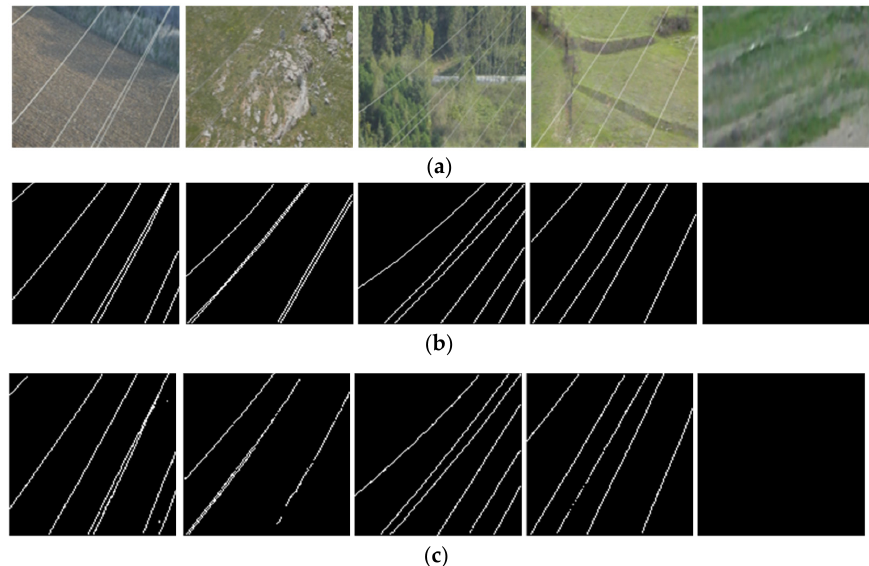
Figure 6. Test results in a foggy environment. The first four show power line scene images, and the last one shows non-power line scene images (order from left to right). ( a ) Power line images in a foggy environment. ( b ) Ground Truth. ( c ) The predicted results of the proposed method.